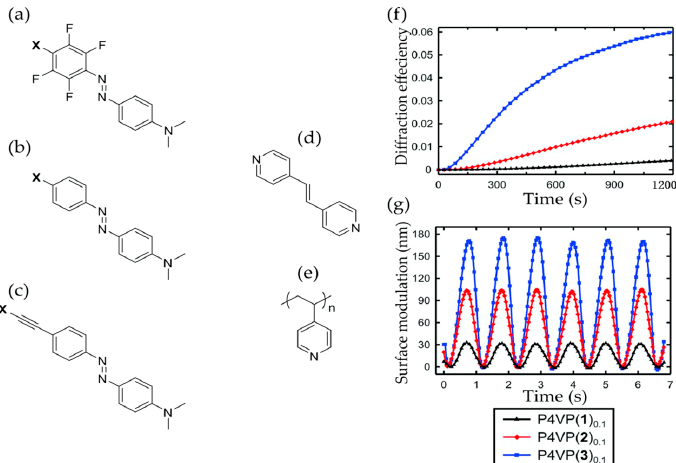
Figure 6. ( a – e ) Chemical structures of the different azobenzene modules (fluorinated ( a ), hydrogenated ( b , c )), dipyridyl compound ( d ) and poly(4-vinyl pyridine) (P4VP, ( e )) used in reference [81]. The label X can be either H, OH, or any halogen. ( f ) Diffraction efficiency of the different fluorinated and ( g ) AFM surface profiles of the gratings for azobenzene modules P4VP( n ) 0.1 ( a ) with n = 1 ( X = F), n = 2 ( X = Br) and n = 3 ( X = I). Reproduced from [81].